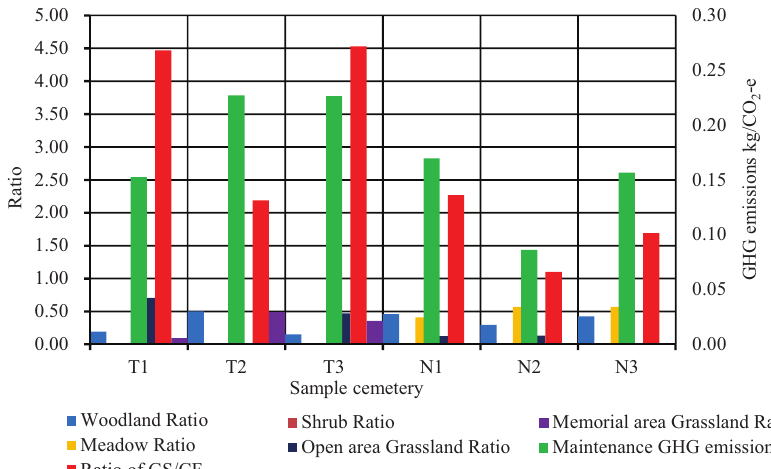
Figure 8. Relations of GHG emissions and